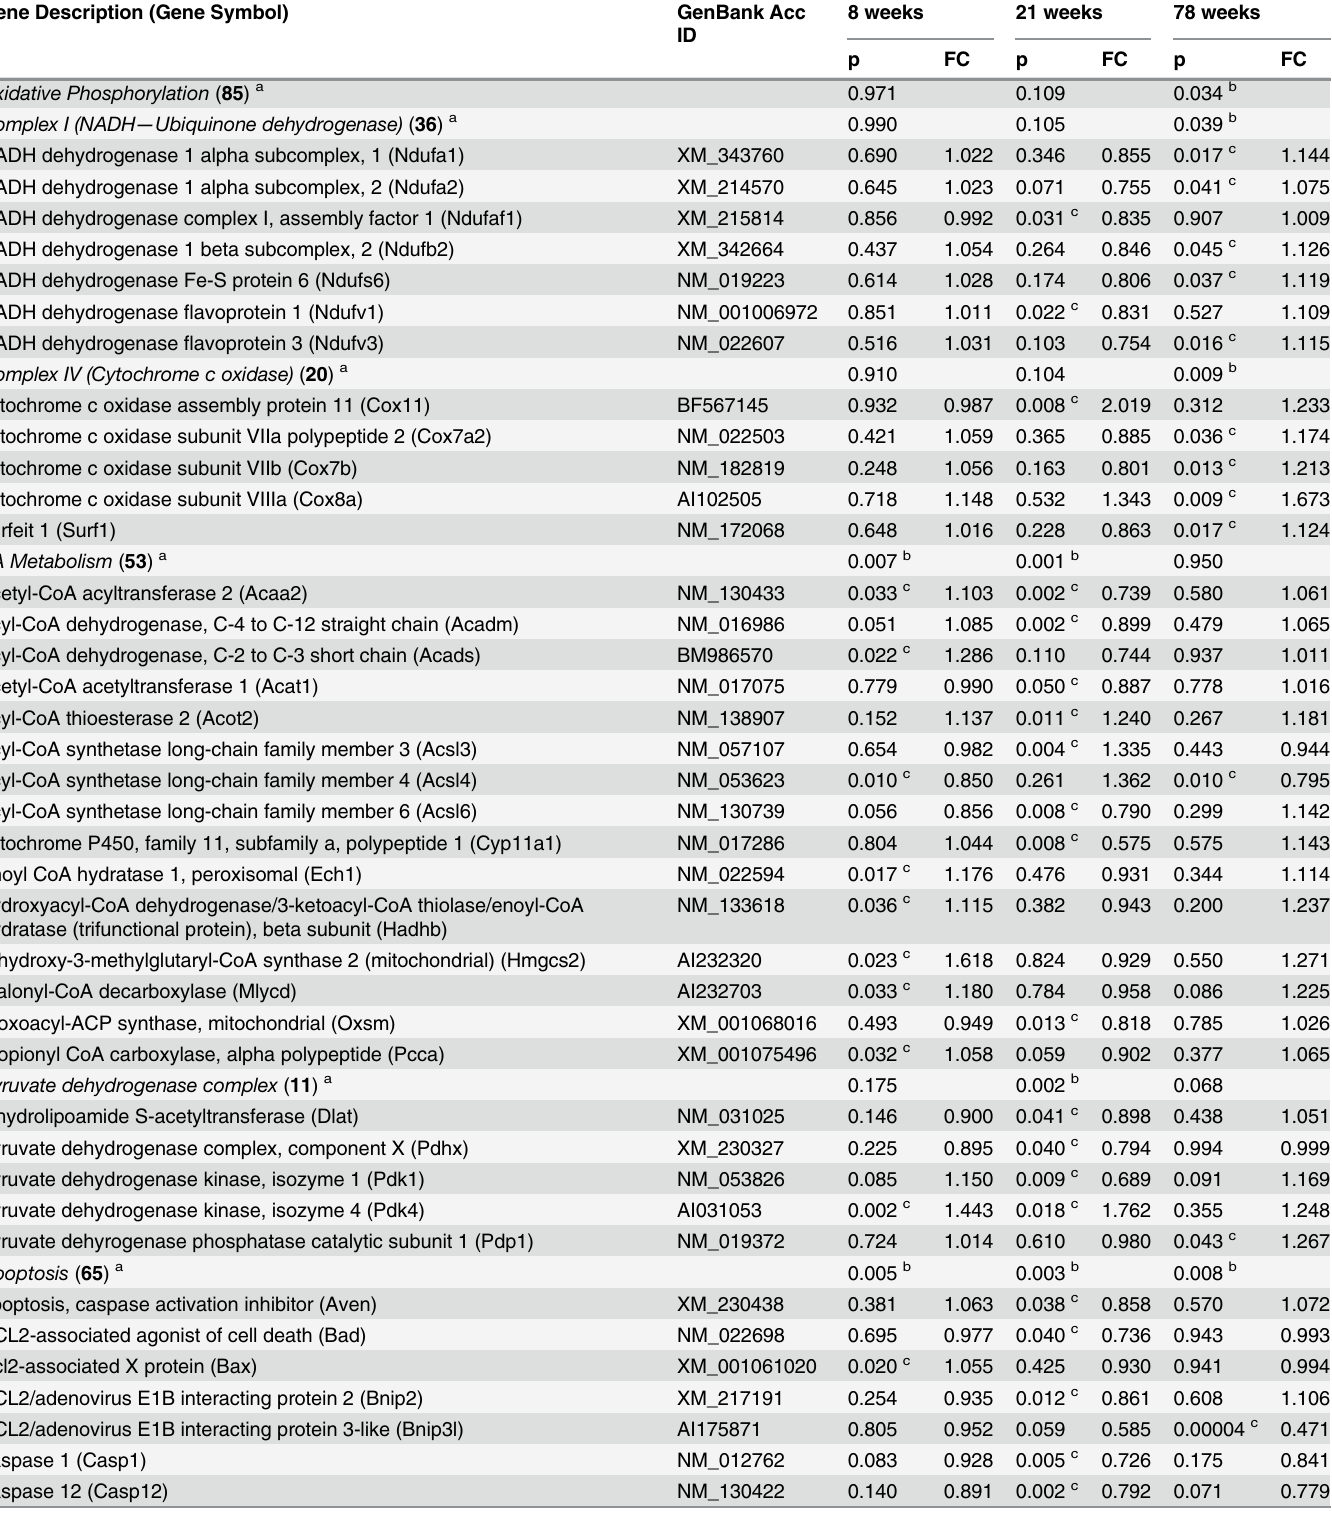
Table 1. Sexually dimorphic gene expression in Fischer 344